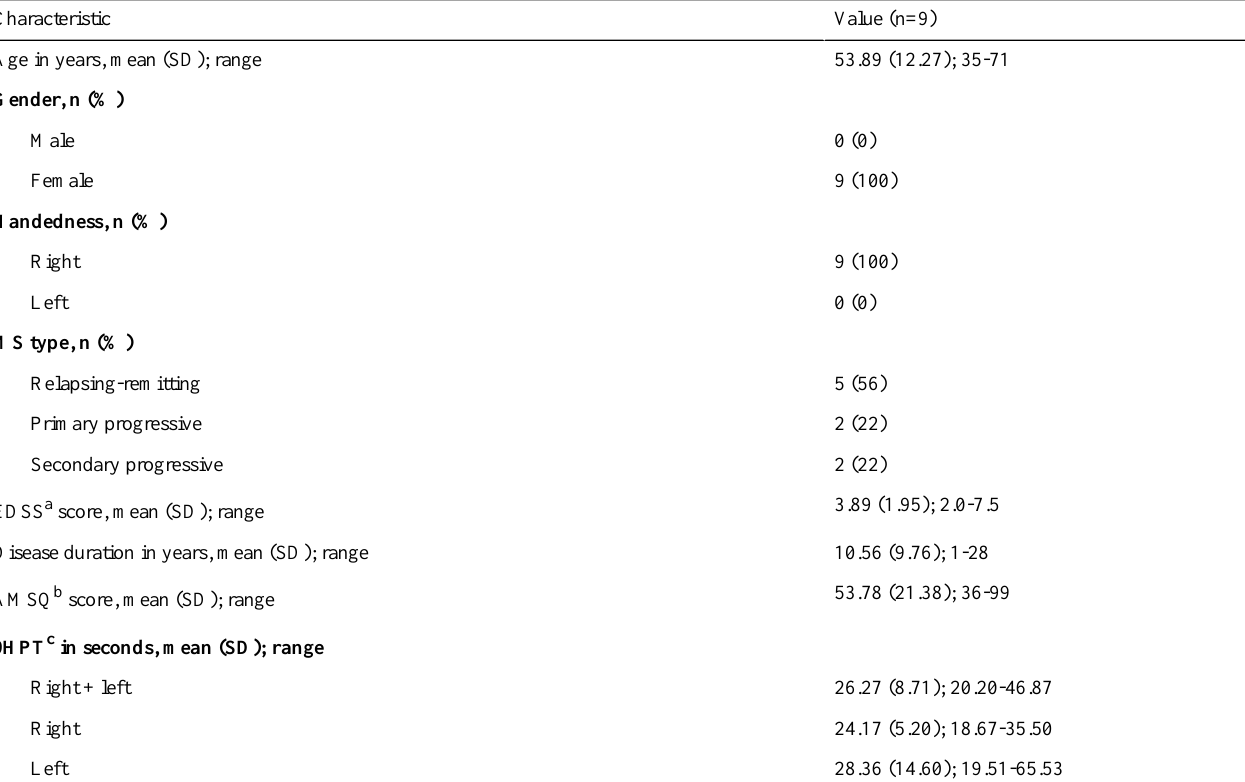
Table 1. Clinical and demographic characteristics of the persons with multiple sclerosis (MS).